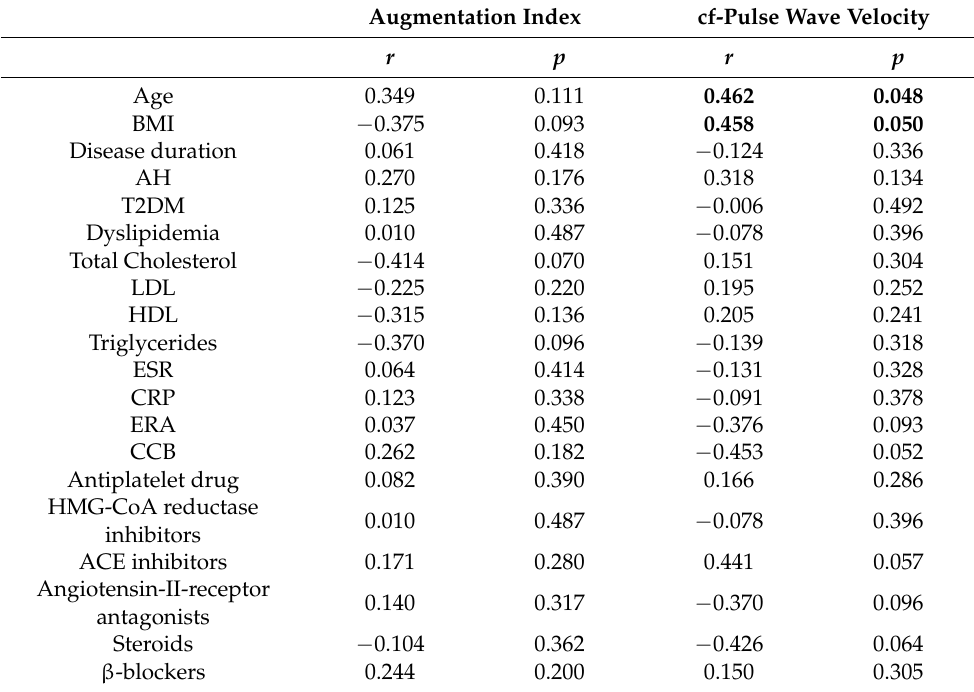
Table 3. Correlations between the variables and arterial stiffness parameters in the SSc